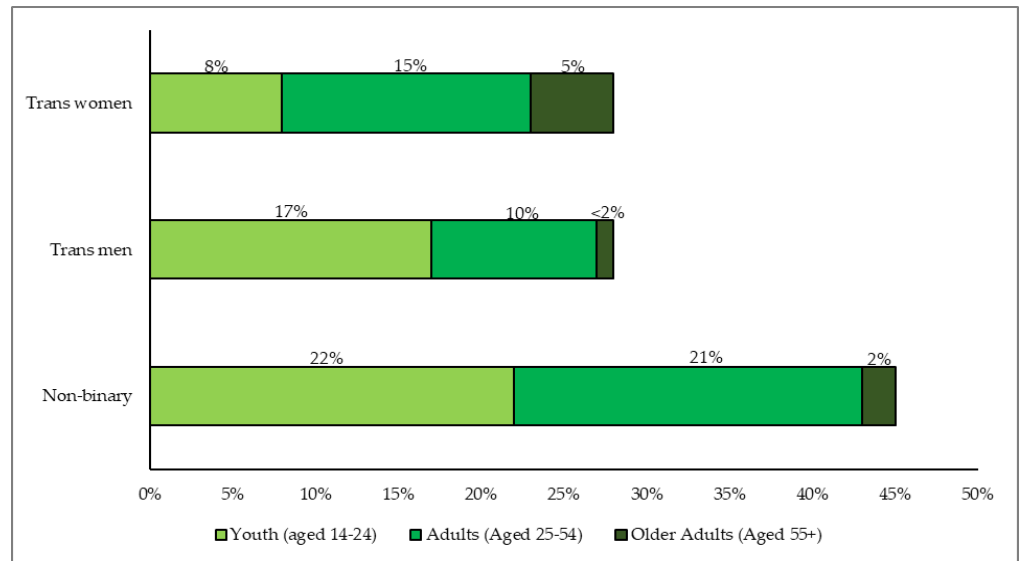
Figure 1. The distribution of gender groups across the lifespan among Counting Ourselves participants.